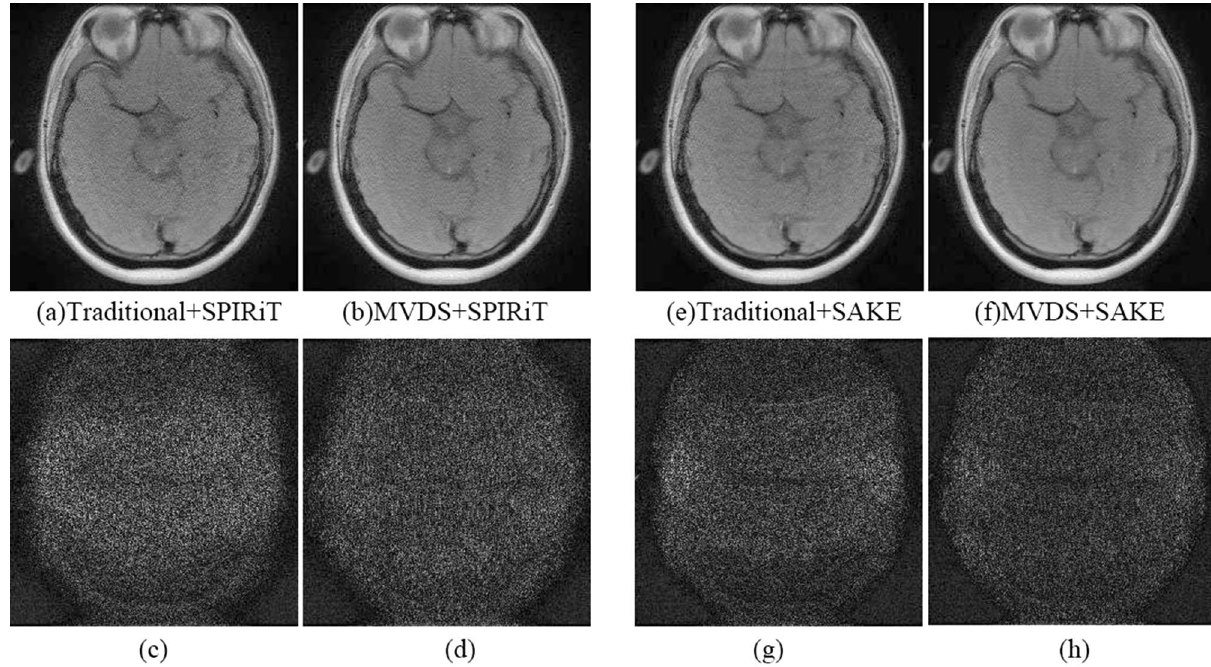
Figure 9. When R = 4 and ACS = 32, use SPIRiT and SAKE to reconstruct the image to compare traditional and MVDS method. SPIRiT: ( a ) the SPIRiT with traditional method and ( c ) the corresponding difference map. ( b ) The SPIRiT with MVDS method, and ( d ) the difference graph; SAKE: ( e ) the SAKE with traditional method and ( g ) the corresponding difference map. ( f ) The SAKE with MVDS method, and ( h ) the difference graph.